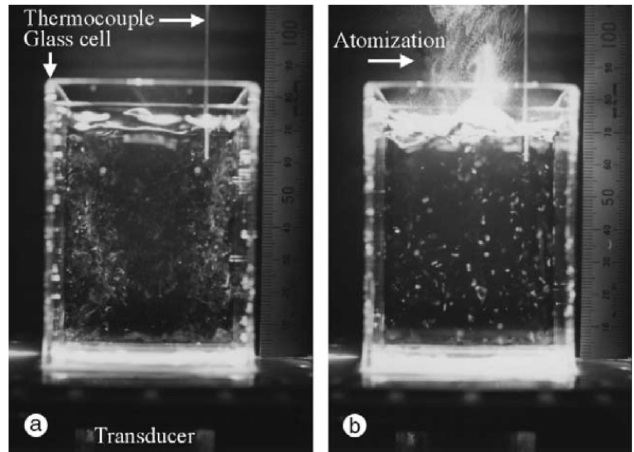
Figure 28. Photographs of cavitation bubbles at 132.2 kHz for the FG outputs of ( a ) 400 mV p-p and ( b ) 450 mV p-p taken with a still camera with 33 ms exposure [68]. Reprinted from Ultrasonics, vol.